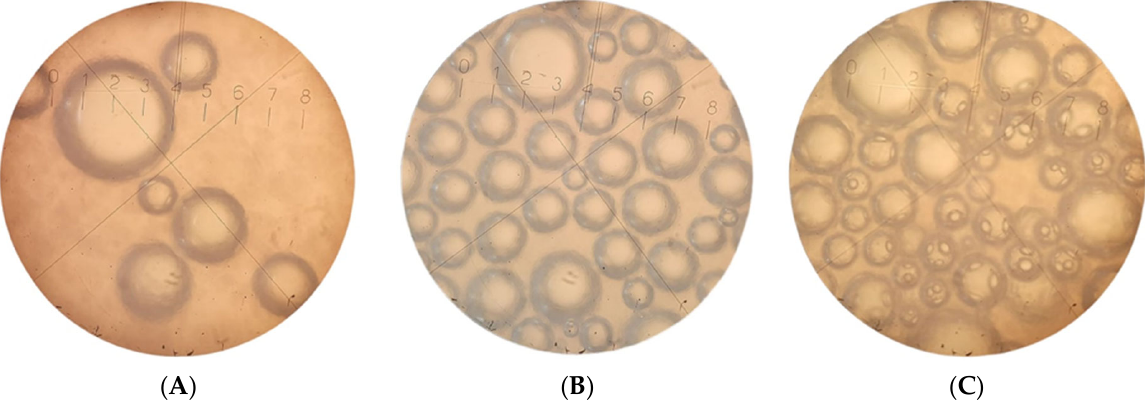
Figure 4. The microstructure of ice cream samples after freezing at a magnification of 160 times: ( A ) low ‐ fat milky ice cream without stabilizer (control); ( B ) low ‐ fat milky ice cream with 0.5% of Cremodan ® SI 320; ( C ) low ‐ fat milky ice cream with 0.5% of oat β‐ glucan.